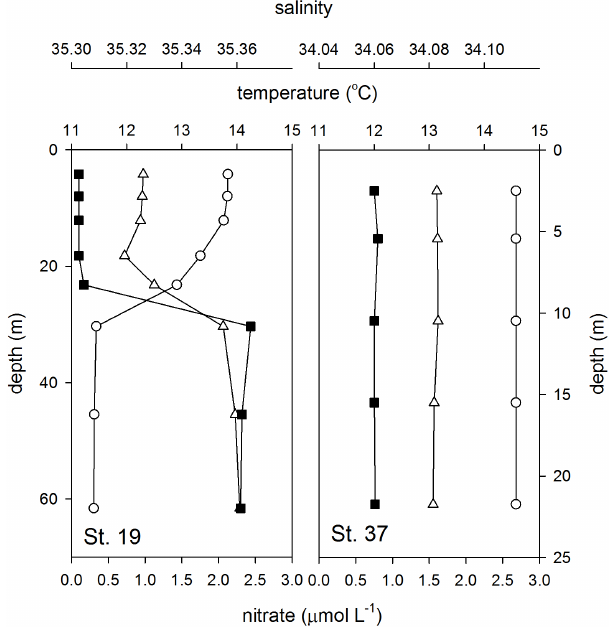
Figure 2. Two example depth profiles of temperature, salinity and nitrate: (a) from station 19 in the western English Channel (15 June 2011; 50 . 029 ◦ N, 4 . 3795 ◦ W) with stratified water column, and (b) from station 37 in the southern North Sea (26 June 2011; 52 . 995 ◦ N, 2 . 501 ◦ E) with a fully mixed water column. Open cir- cles: temperature; open triangles: salinity; black squares: